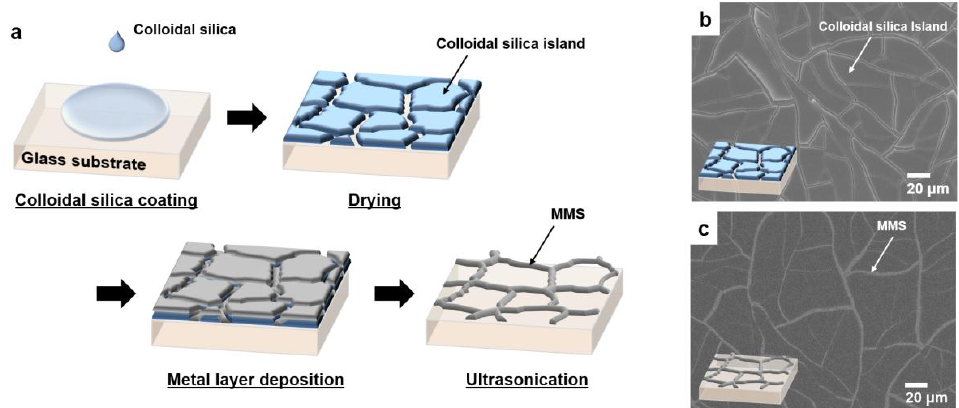
Figure 1. ( a ) Schematic diagram of the fabrication process for a metal-mesh structure (MMS) using a cracked template; scanning electron microscopy (SEM) images of ( b ) colloidal silica layer on the substrate after drying; and ( c ) fabricated MMS. Insets in (b) and (c) show the schematic diagram of each